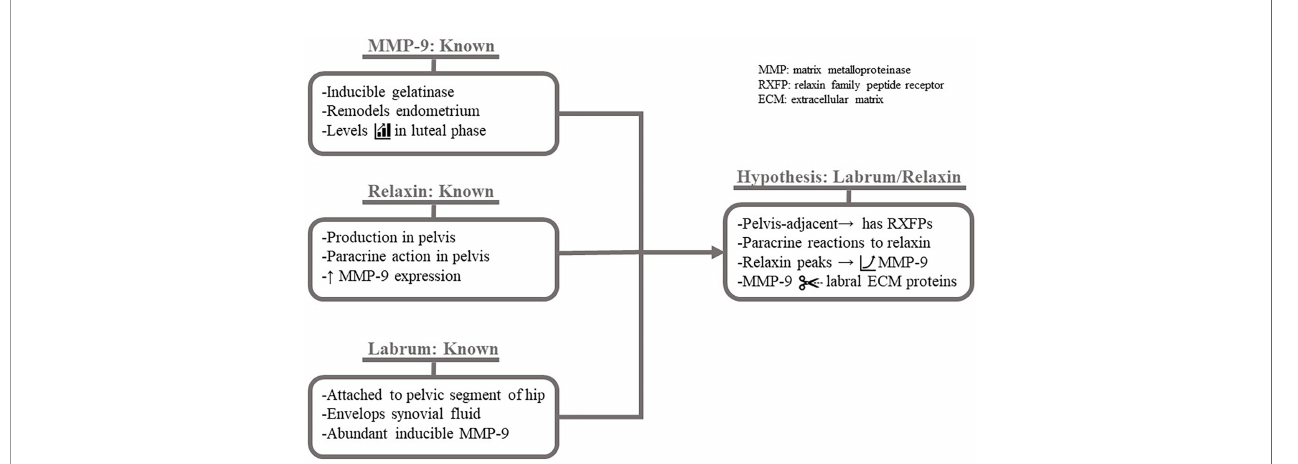
FIGURE 3 | Hypothesized mechanism of relaxin-induced acetabular labrum damage. Known factors giving rise to hypothetical impact of relaxin on the acetabular labrum. It is known that MMP-9 is the inducible gelatinase (MMP-2 is not) which is expressed at high levels during the luteal phase for endometrial. It is known that relaxin, produced in the pelvis and exerting paracrine effects, increases MMP-9 expression. Finally, it is known that the anchored to the pelvis serves as a "seal" enclosing synovial fl uid, which may contain hormones, and that the cells express MMP-9 at an unusually high level when induced . Given these known factors: the acetabular labrum likely expresses RXFPs and increases MMP-9 expression in a paracrine to relaxin. MMP-9 degrades ECM proteins, weakening the